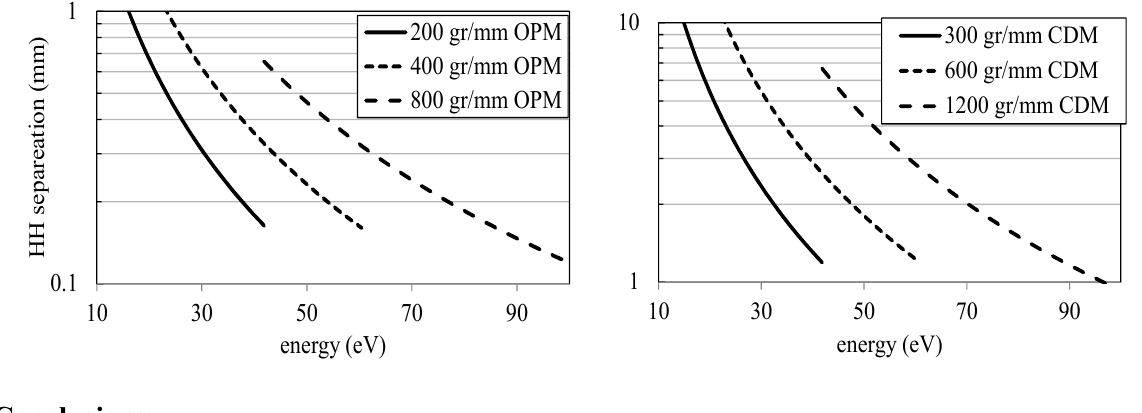
Figure 9. Separation between neighboring harmonics at the monochromator exit